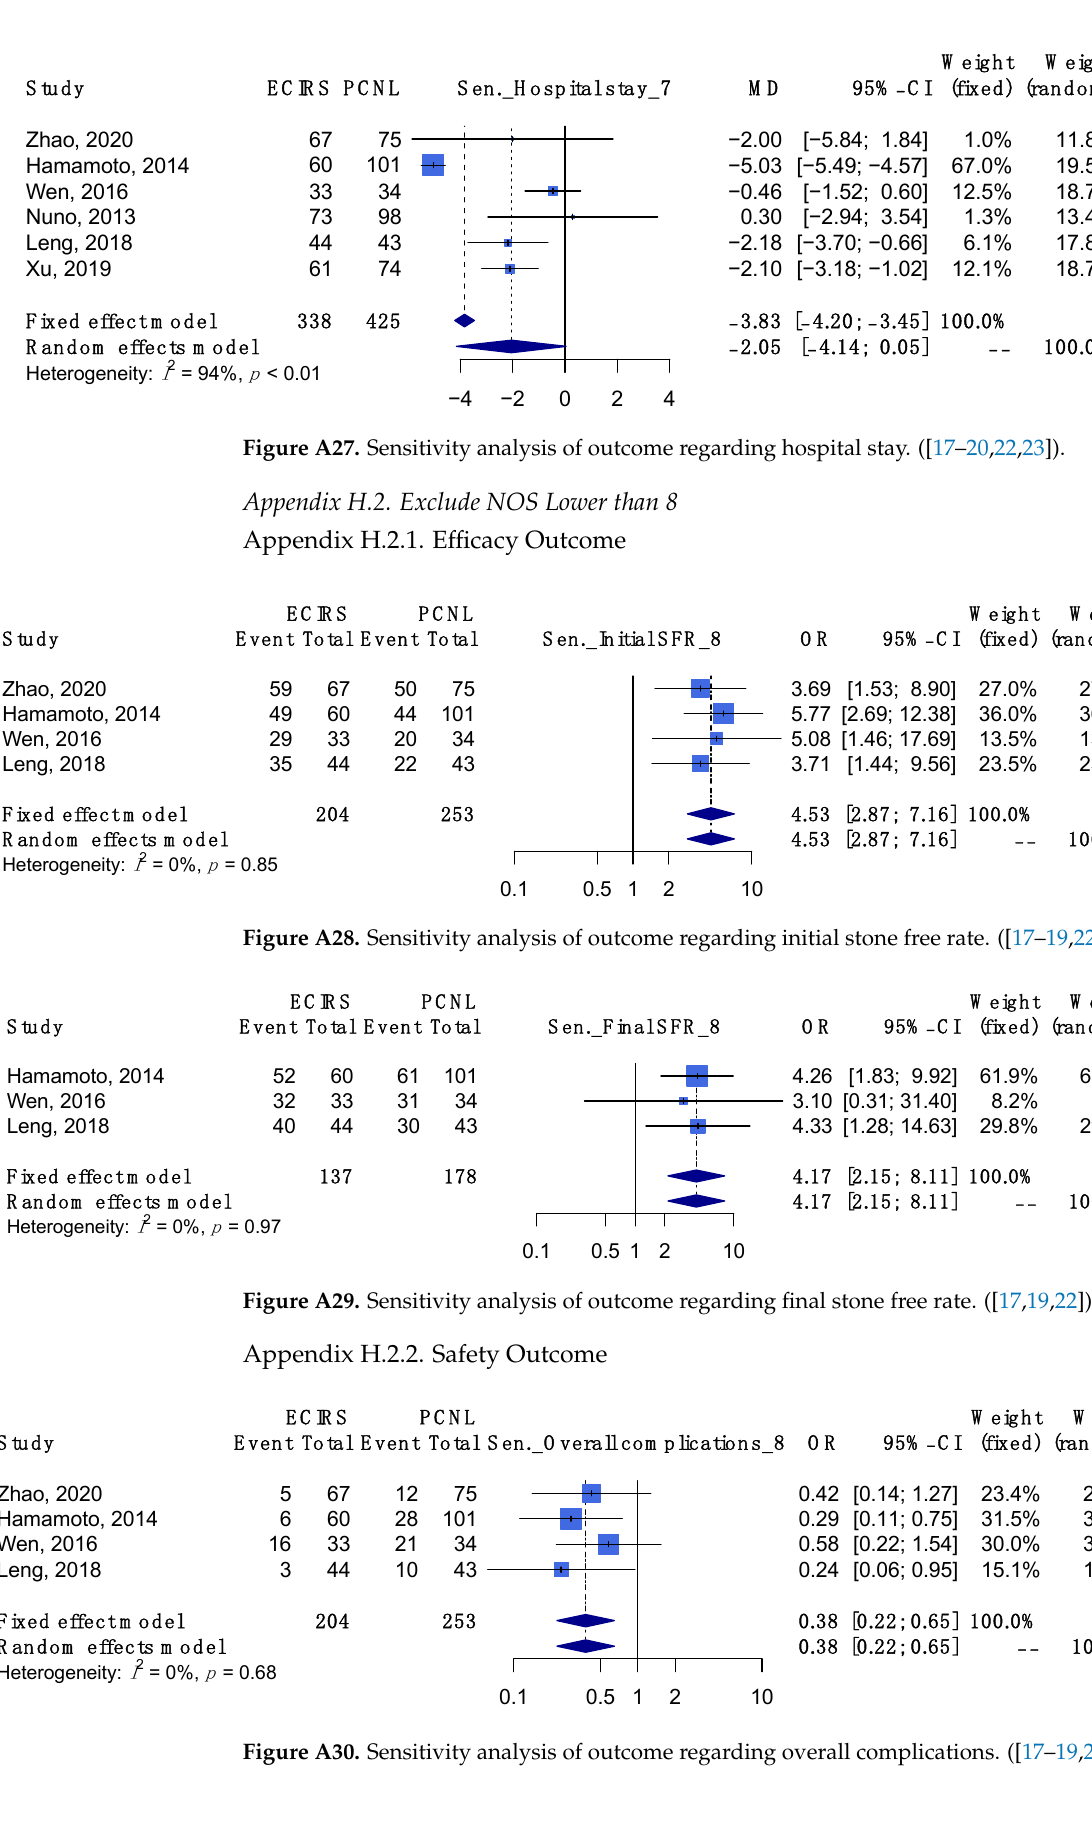
Figure A26. Sensitivity analysis of outcome regarding operative time. ([17–19,22,23])